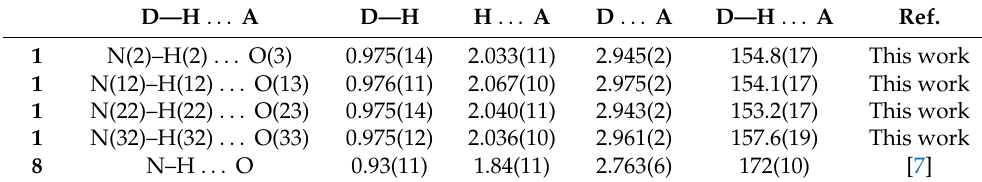
Table 2. Hydrogen-bonding parameters for 1 (Å, °).